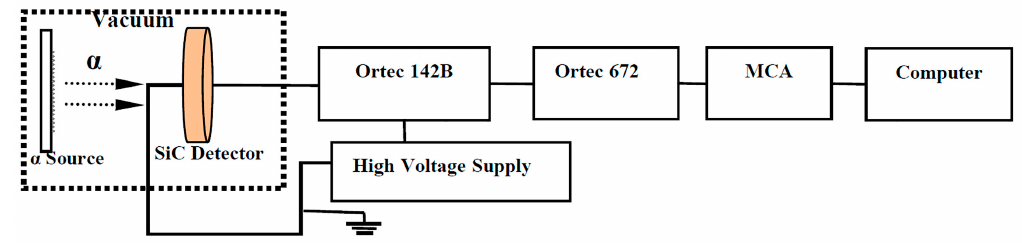
Figure 2. Experimental setup for alpha particle detection with the SiC detector.